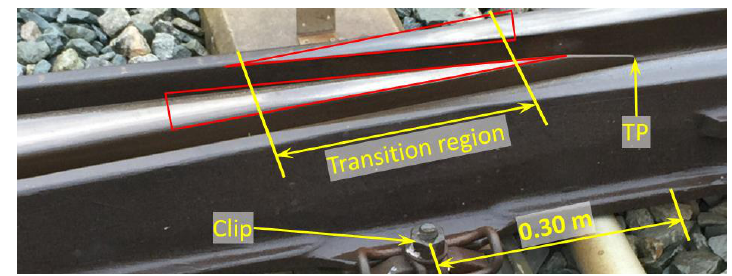
Figure 20. Transition region inspection of the monitored 1:9 trailing crossing.